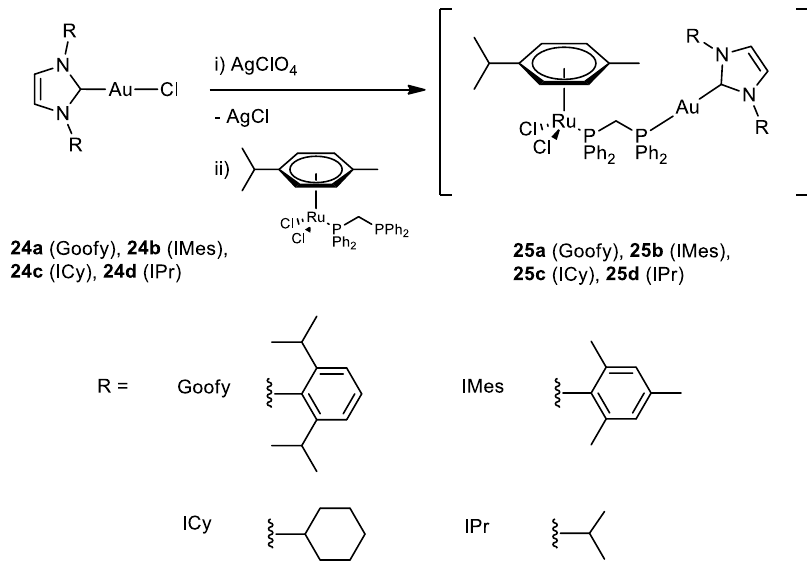
Figure 12. Molecular structure of compounds 24a – d and 25a – d .